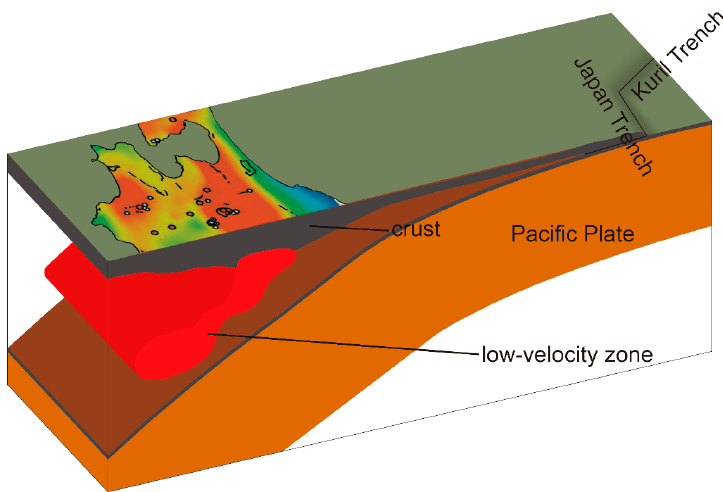
Figure 5. 3D concept model of the crust and upper mantle structure of Aomori Prefecture (modified from Hasegawa et al. [23]).